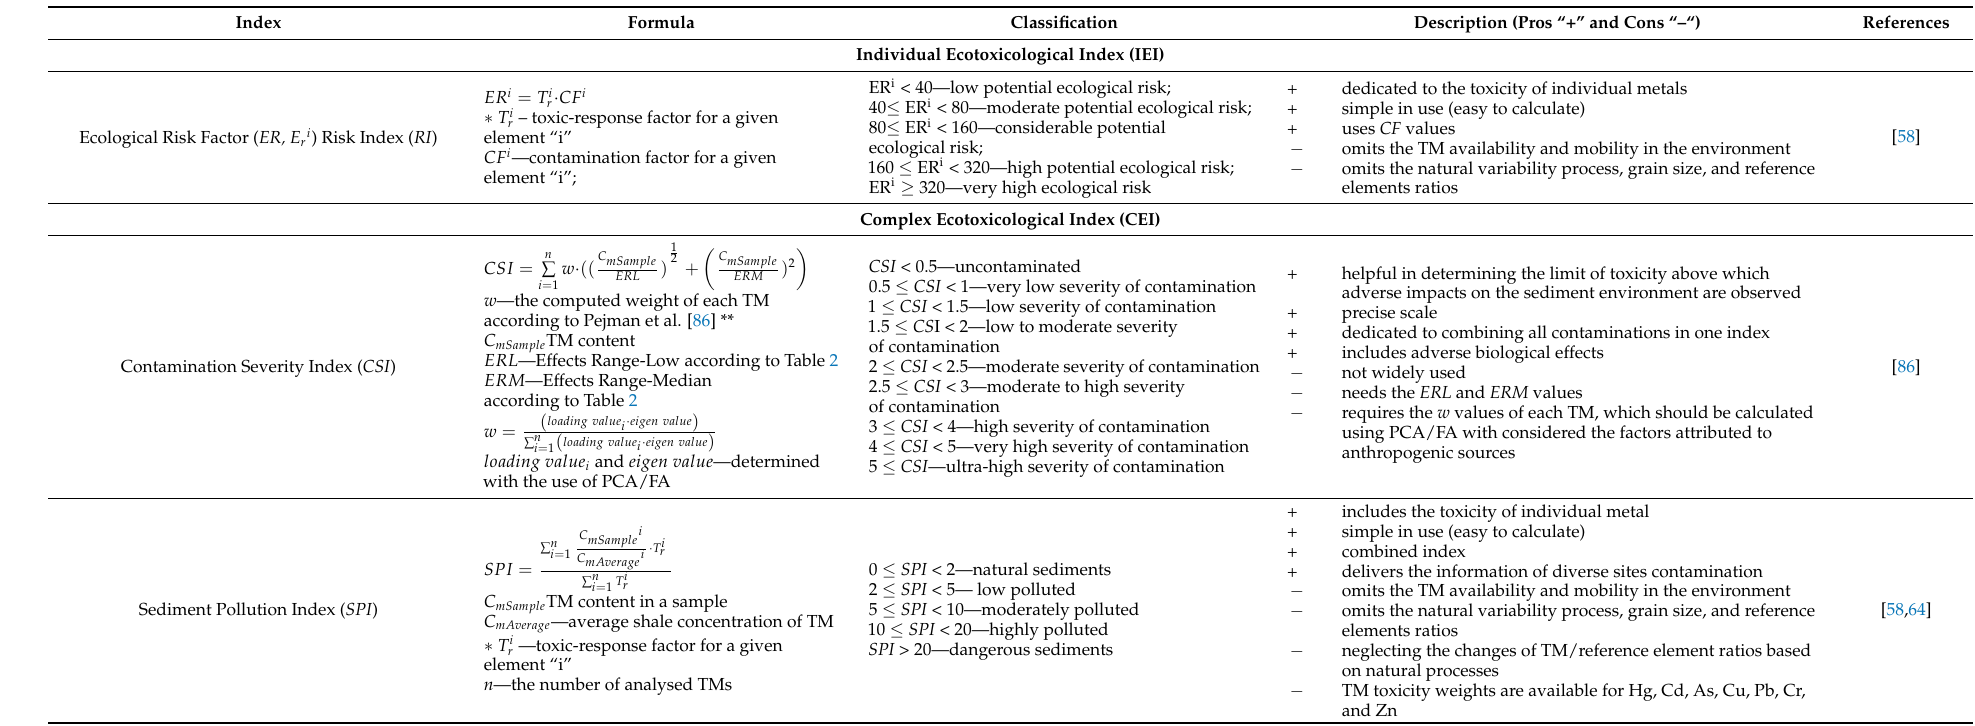
Table A4. A list of ecotoxicological indices (EIs) given in the literature with classification and basic description of strengths and